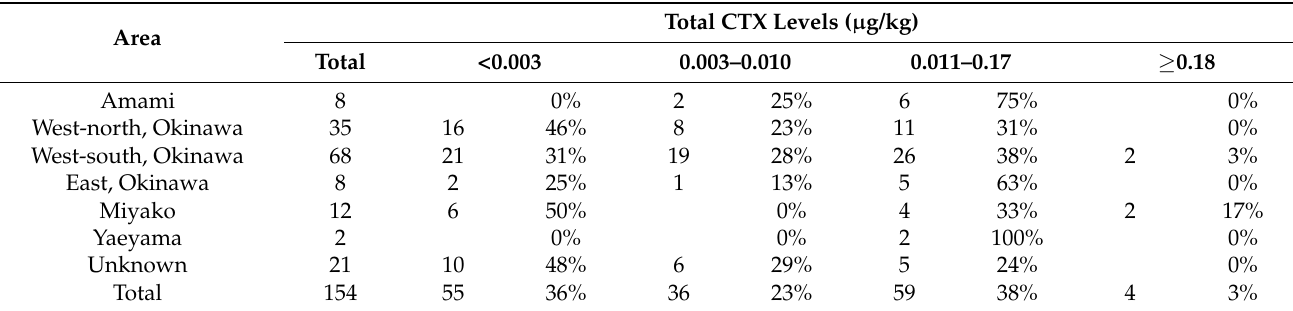
Table 1. CTX levels in the flesh of V. louti specimens collected off the Ryukyu Islands,